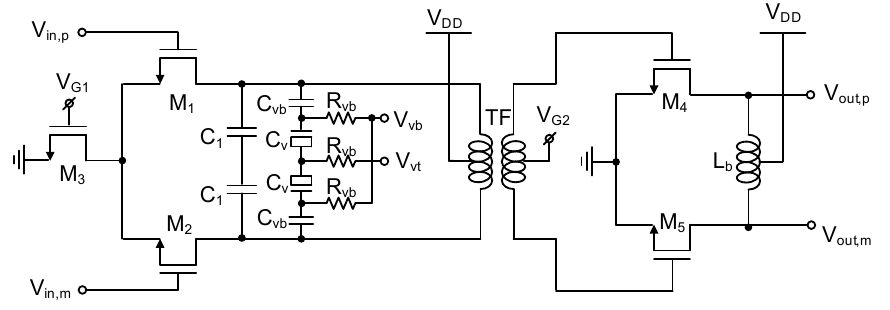
Figure 8. Phase ‐ tunable LO buffer schematic. Figure 8. Phase-tunable LO buffer schematic.